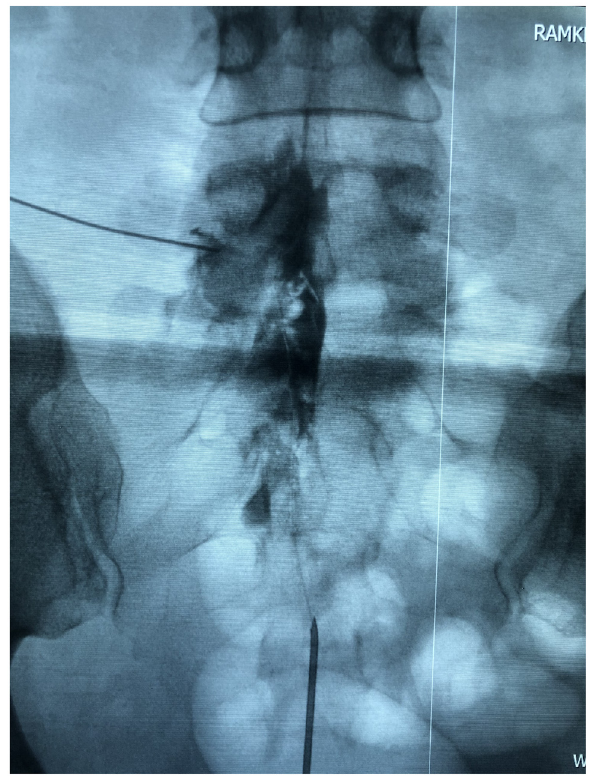
Figure 2. An lateral view of contrast flow in combined supraneural transforaminal and caudal with catheter